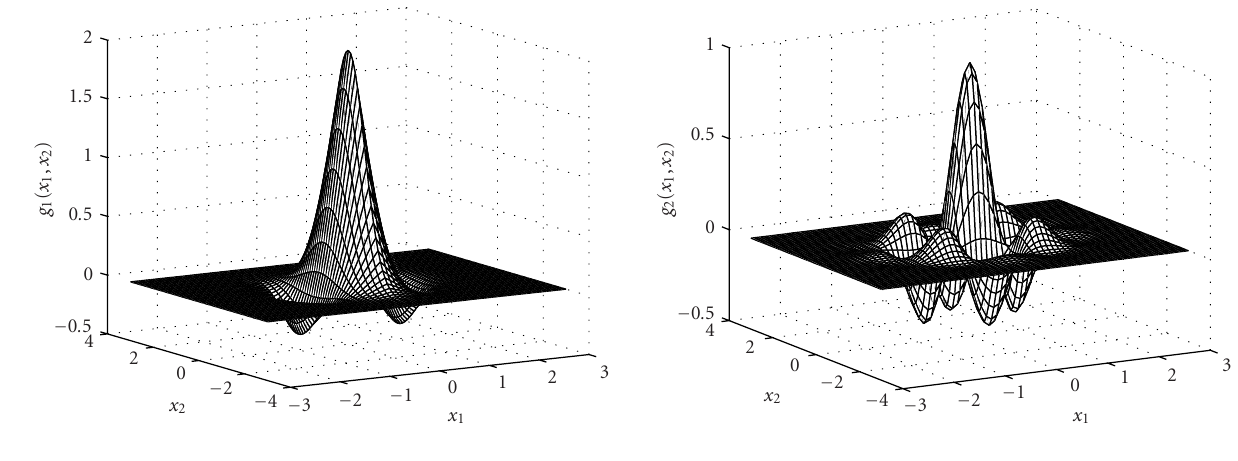
Figure 1: Generating functions g 1 and g 2